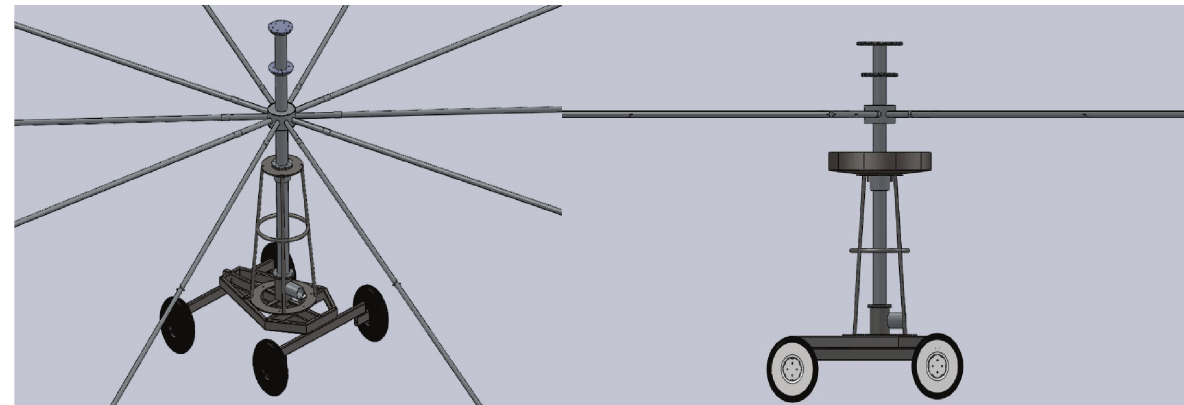
Figura 1. Desenhos esquemáticos que fazem parte do projeto, mostrando detalhes do simulador de chuva movido hidraulicamente por